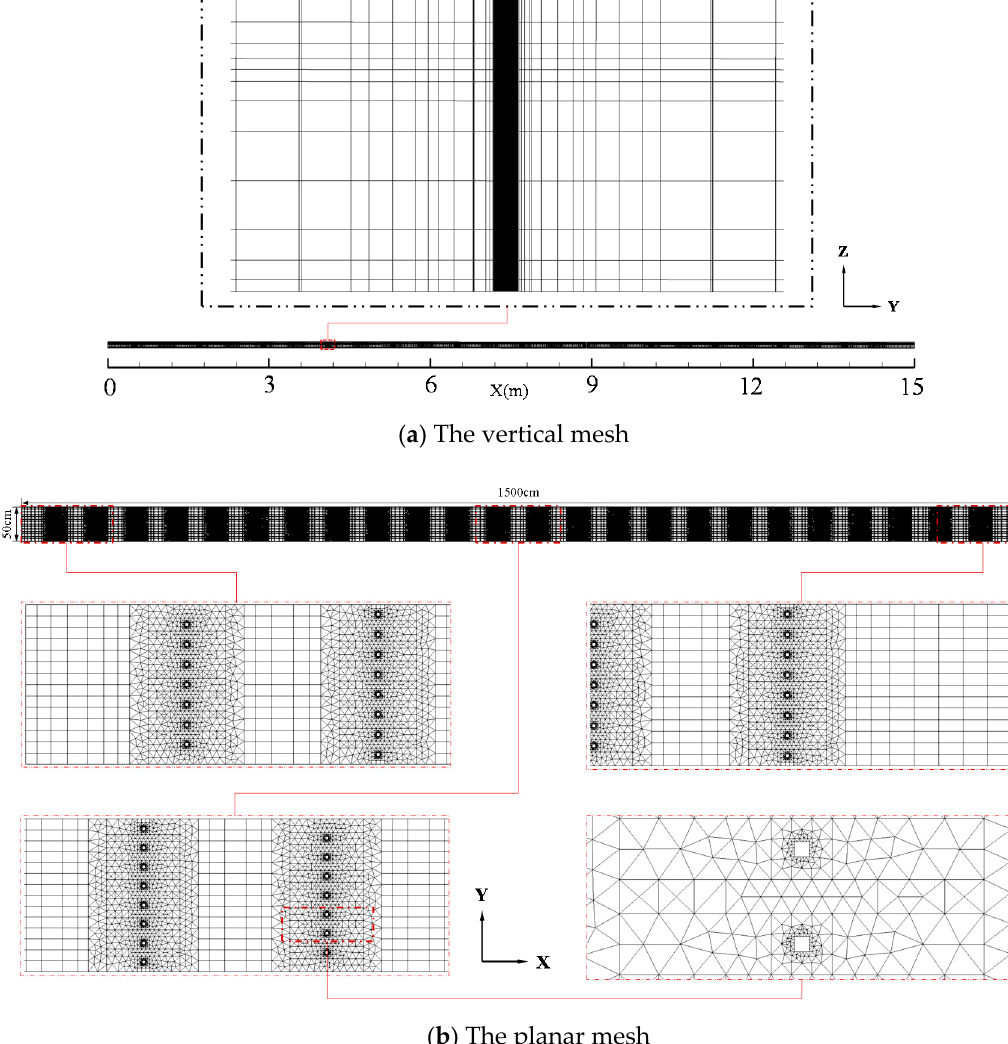
Figure 3. The mesh of calculative region with vegetation.